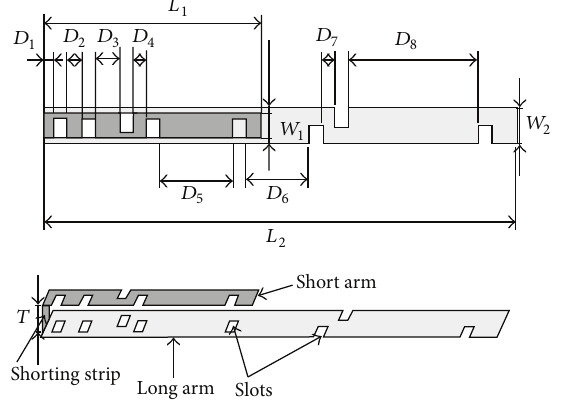
Figure 1: Geometry of the new wideband antenna.